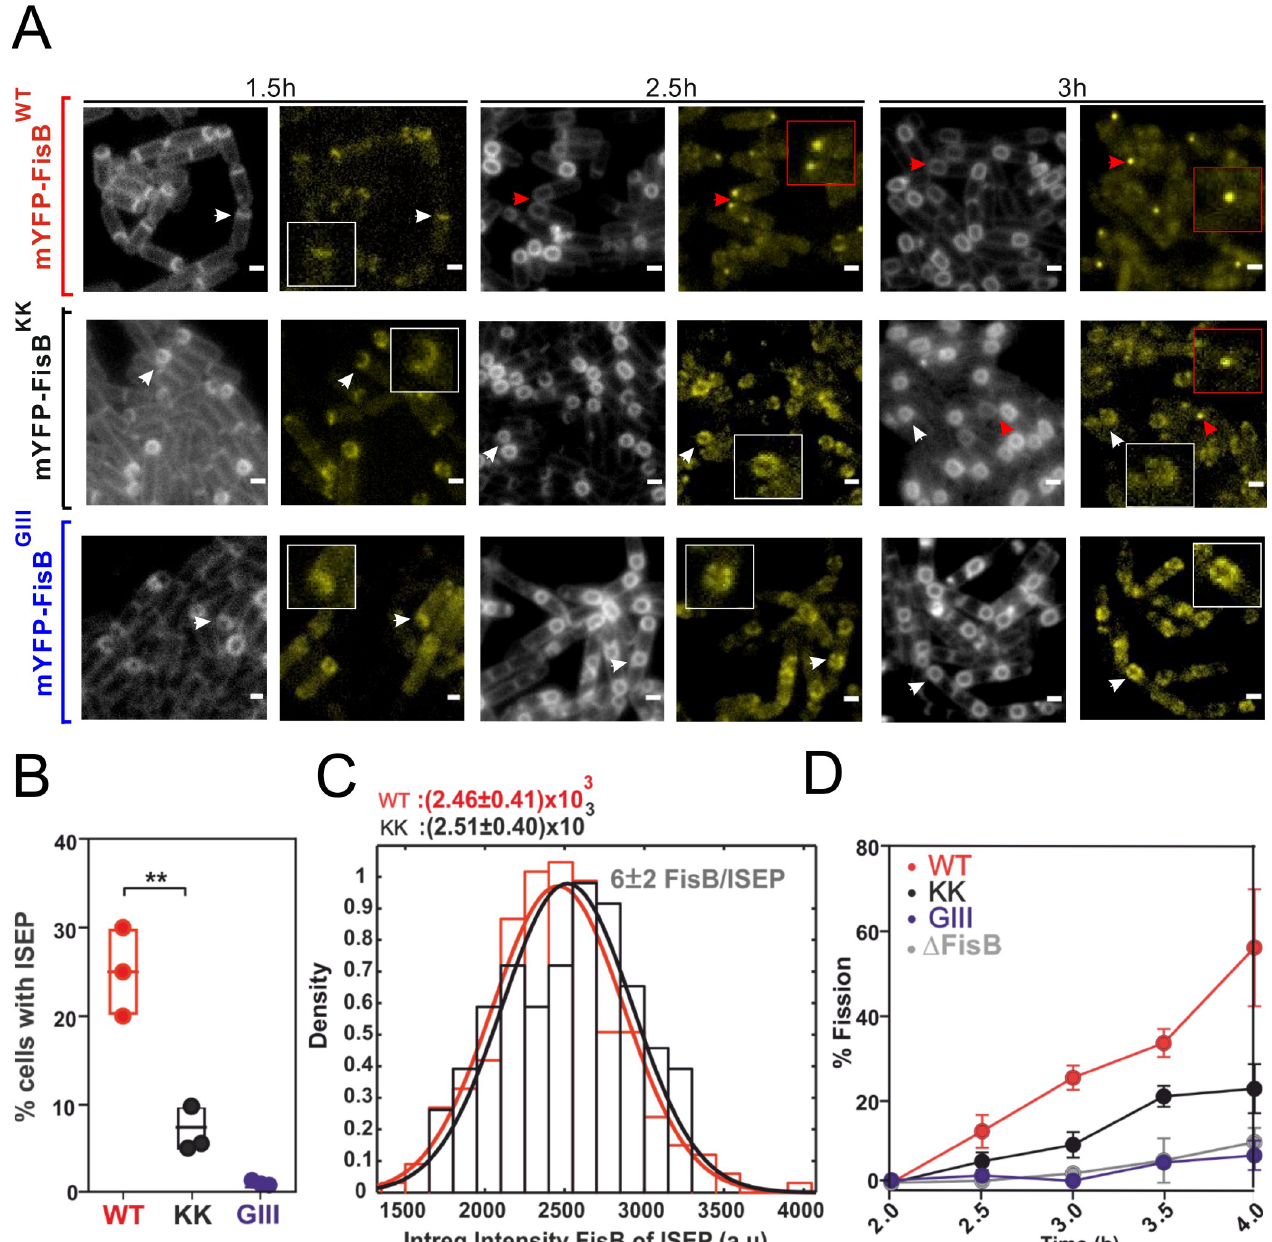
Fig 6. FisB clustering and binding to acidic lipids are both required for ISEP formation and membrane fission. (A) Snapshots of sporulating Δ fisB cells expressing mYPF-FisB WT (BAL002), mYPF-FisB KK (BAL006), or mYPF-FisB GIII (BAL007) at low levels. For each time point after downshifting to the sporulation medium, cell membranes were labeled with TMA-DPH, and images were taken both in the membrane (left) and the YFP (right) channels. By t = 2.5 hours, some foci at the engulfment pole (ISEP) are visible for WT cells that have undergone membrane fission (red boxes), but not for the KK or GIII mutants (white boxes). A small fraction of KK mutants (7.3%) accumulated FisB at the engulfment pole and underwent membrane fission at t = 3 hours. Scale bars represent 1 μ m. (B) Percentage of cells with an intense spot at the engulfment membrane (ISEP) at t = 3 hours into sporulation, for WT FisB, FisB KK , or FisB GIII . For every strain, 200–300 cells from 3 independent experiments were analyzed at the indicated times during sporulation. (C) Distribution of background-corrected integrated intensities (sum of pixel values) of ISEP fluorescence for Δ fisB cells expressing mYFP-FisB WT or mYPF-FisB KK . The distributions are indistinguishable. Since low-expression cells accumulate, on average, 6 ± 2 FisB WT molecules at the ISEP (S4D Fig), so do FisB KK cells. A total of 175 and 68 ISEPs were analyzed for WT and KK mutant strains. (D) Percentage of cells that have undergone membrane fission at the indicated time points. (For every strain, 200–300 cells from 3 independent experiments were analyzed at the indicated times during sporulation.). FisB, fission protein B; ISEP, intense spot at the engulfment pole; mYFP, monomeric YFP; WT, wild-type.